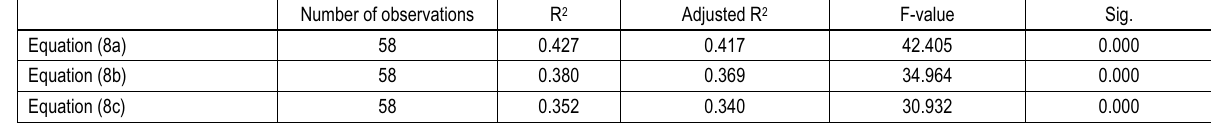
Table 3. Results of regression analysis of the three benchmark residual income valuation models